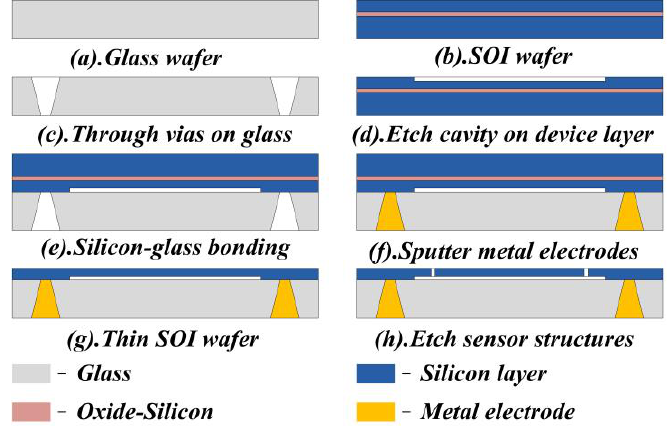
Figure 2. Fabrication process of the micro-floating element wall shear stress sensor with backside connections.